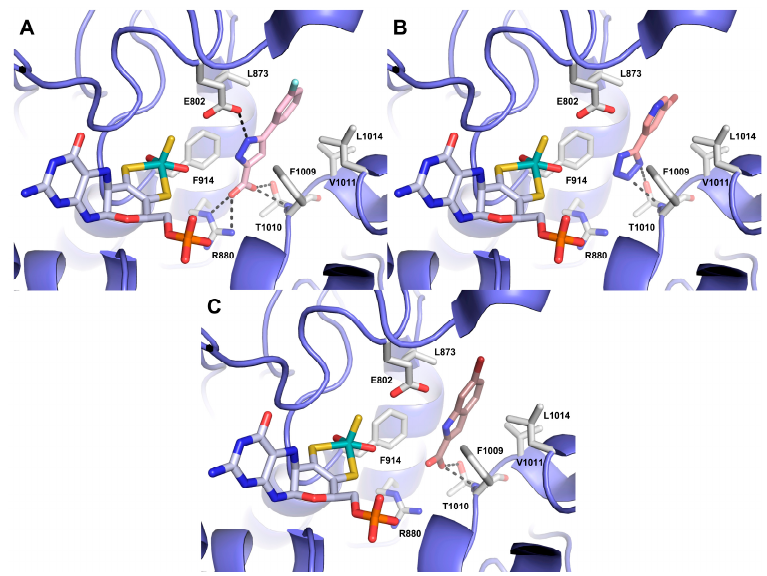
Figure 6. Predicted binding modes of compounds ALS-8 (( A ), pink sticks), ALS-15 (( B ), salmon sticks) and ALS-1 (( C ), dirty violet sticks) into XO (slate ribbons, PDB 1N5X). Only amino acids discussed in the main text are displayed (white sticks) and labelled. H-bonds discussed in the text are depicted as dashed black lines.